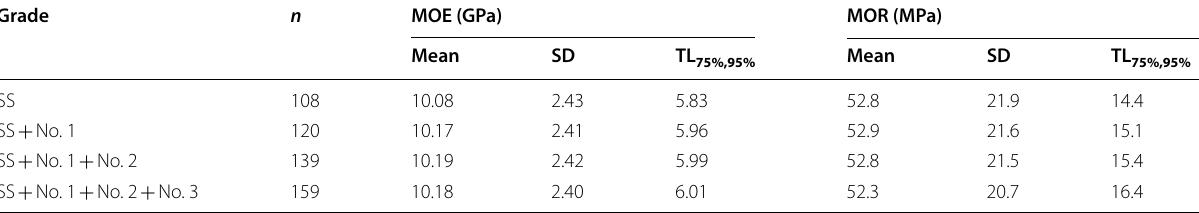
n number of lumber, MOE modulus of elasticity, MOR modulus of rupture, SD standard deviation, SS select structural, TL 75%,95% , 5% lower limit with a 75% confidence level (5% tolerance limit) Table 4 Mean values and standard deviations of the air-dry density and bending properties of lumber in each visual grade Grade